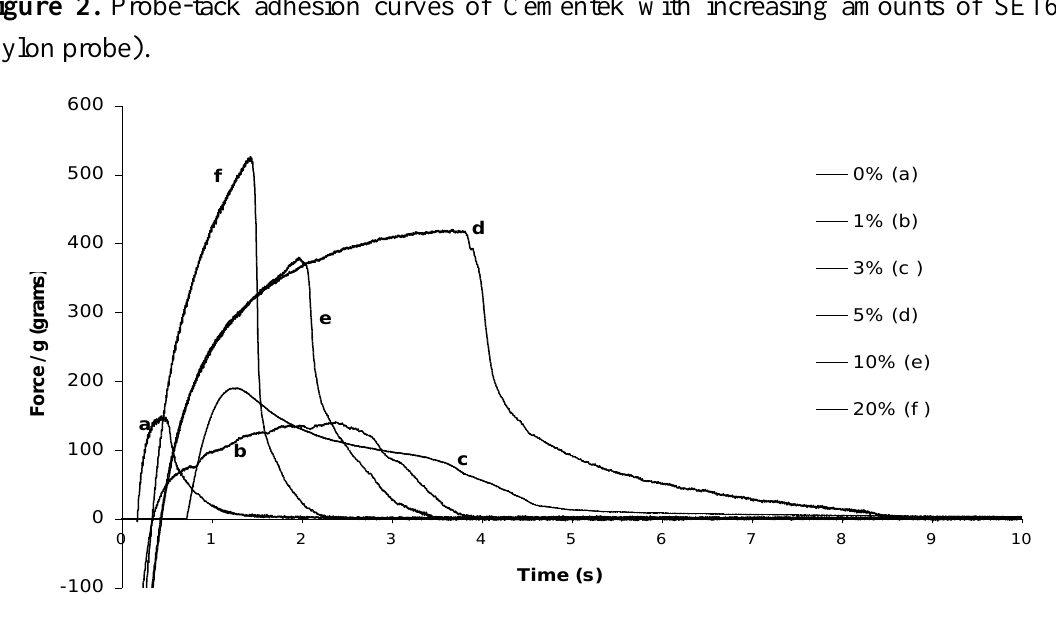
Figure 3. Probe-tack adhesion curves of Cementek with different surfactants (bone